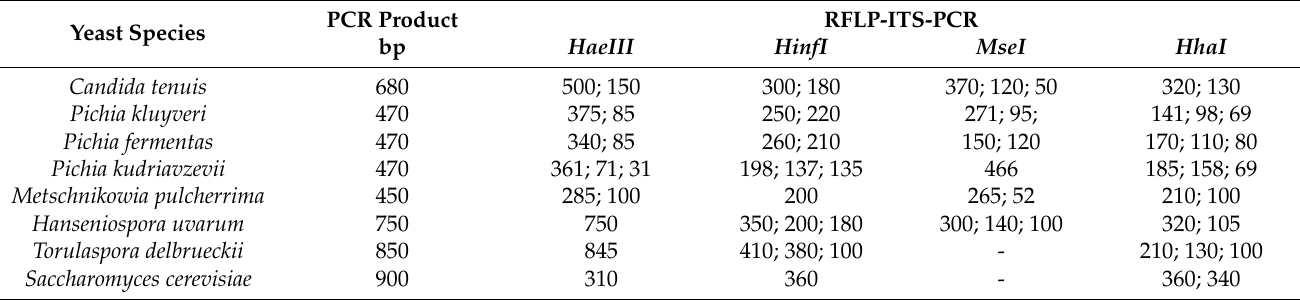
Table 3. PCR products and restriction patterns of